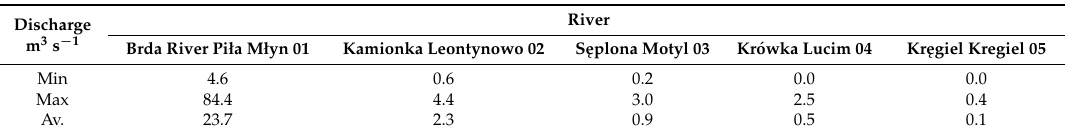
Table 1. Discharge of the main Koronowski Reservoir tributaries (1962–2015) ([24] and own research